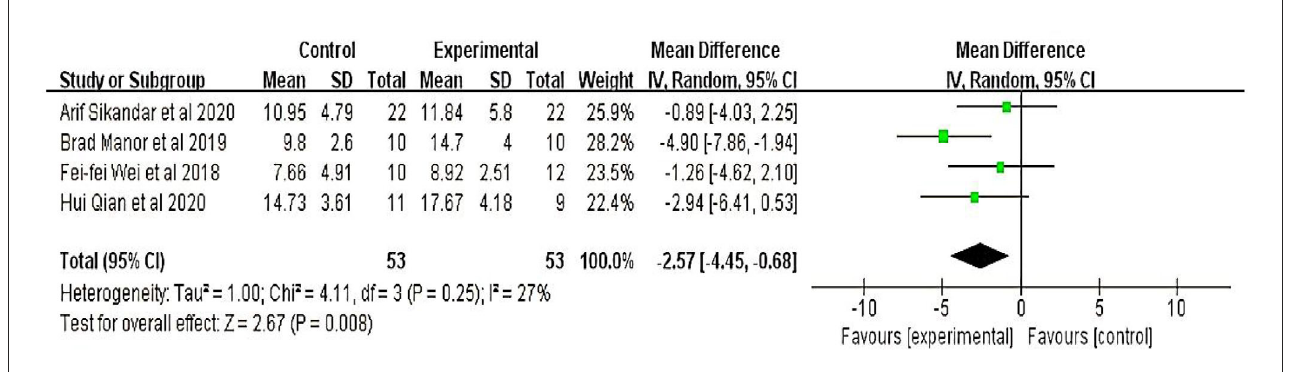
FIGURE1 Scale for the assessment and rating of ataxia (SARA).